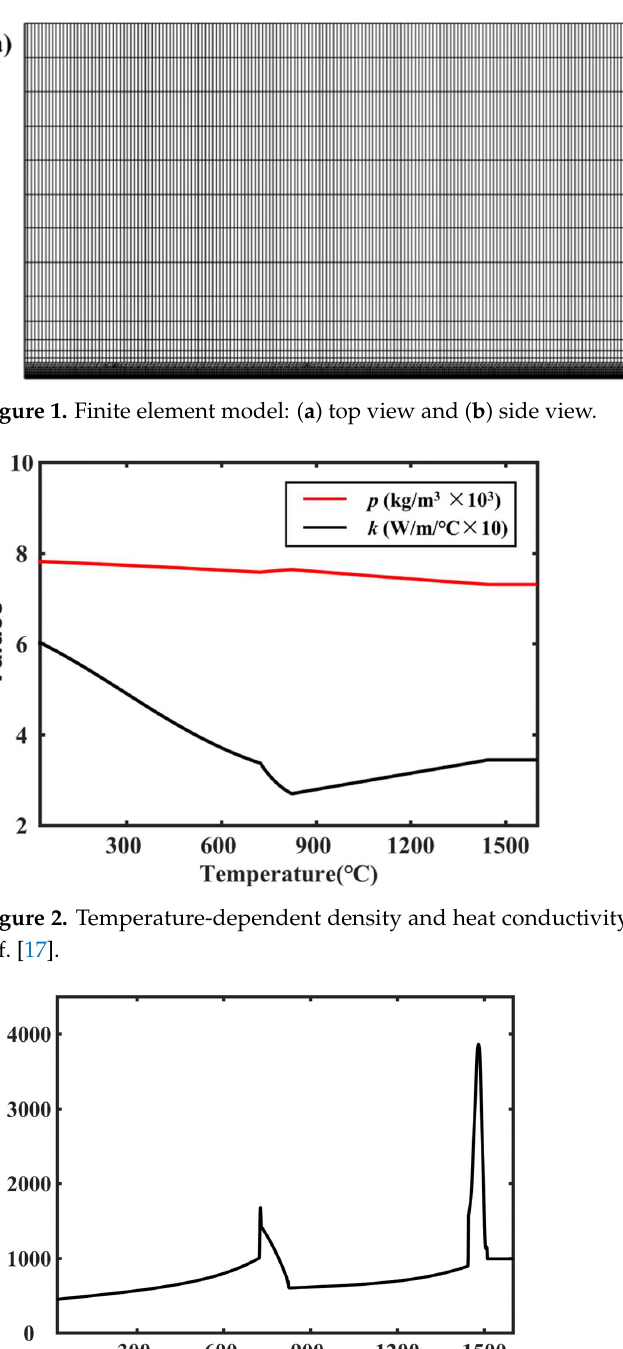
Figure 3. Temperature-dependent specific heat capacity of 1700MS, data from ref. [17].